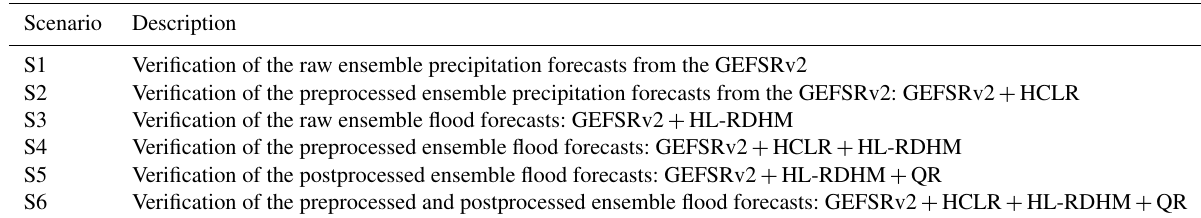
Table 2. Summary and description of the verification scenarios.